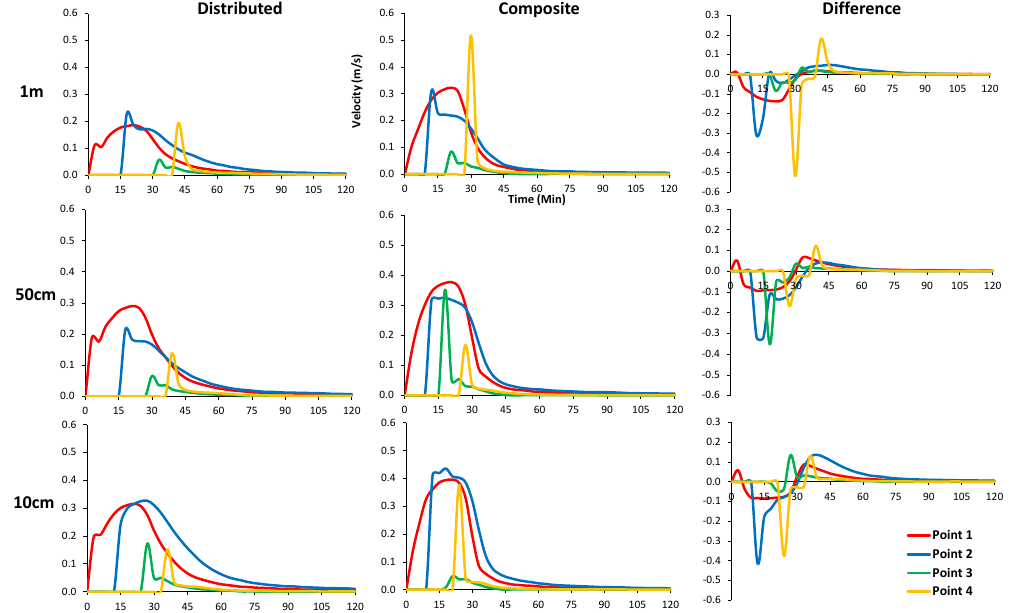
Fig. 10. Simulated velocity over time at the four control points across the different resolutions using distributed and composite frictions and difference plots (distributed minus composite). (All y axes show velocity as ms − 1 , all x axes show time as